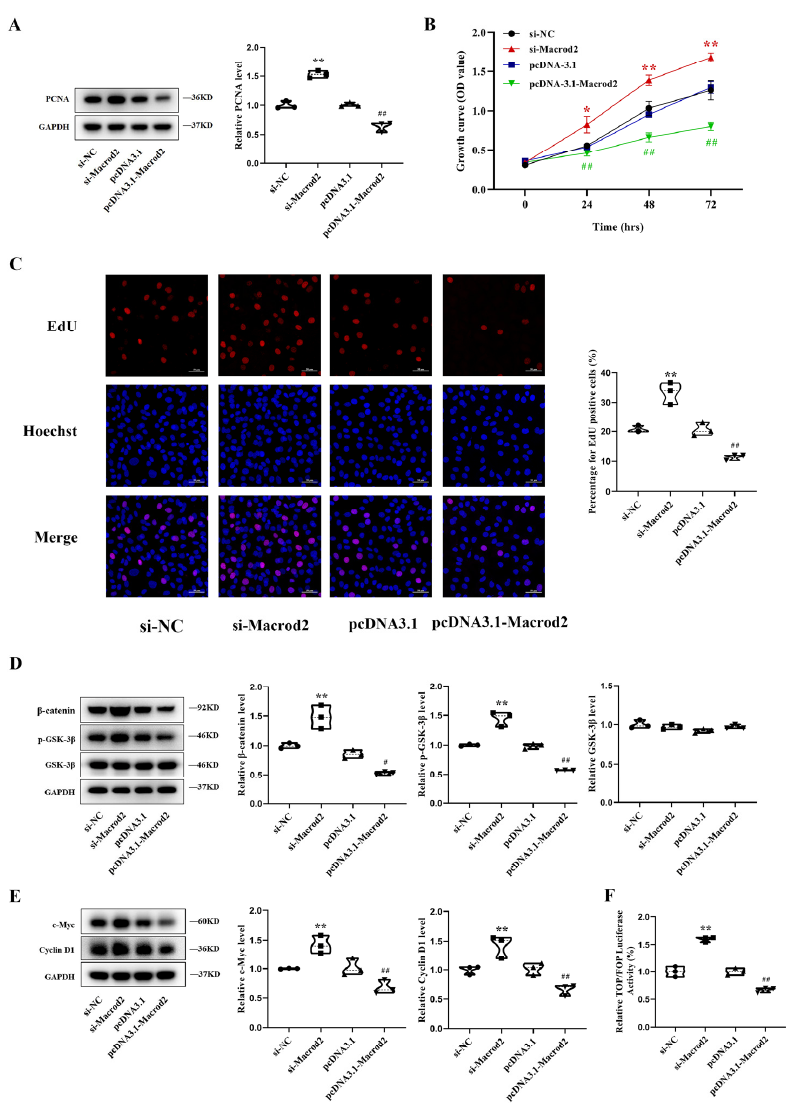
Figure 4. Macrod2 inhibits osteoblast proliferation in MC3T3-E1 cells. ( A ) Protein levels of PCNA in MC3T3-E1 cells by Western blotting in MC3T3-E1 cells transfected with si-Macrod2, pcDNA3.1- Macrod2, or the corresponding controls ( n = 3). One-way ANOVA followed by LSD’s multiple comparisons test. ( B ) Cell proliferation as assessed by a CCK-8 assay in MC3T3-E1 cells in the indicated groups ( n = 3). Repeated measures ANOVA. ( C ) The EdU positive cells showed by EdU labeling assays after treatment with si-Macrod2, pcDNA3.1-Macrod2, or the corresponding controls in MC3T3-E1 cells ( n = 3). Scale bar, 50 μ m. One-way ANOVA followed by LSD’s multiple comparisons test. ( D ) Western blotting analysis of β -catenin, p-GSK-3 β , and GSK-3 β in MC3T3-E1 cells ( n = 3). One-way ANOVA followed by LSD’s multiple comparisons test. ( E ) Western blotting analysis for c-Myc and Cyclin D1 protein levels in MC3T3-E1 cells ( n = 3). One-way ANOVA followed by LSD’s multiple comparisons test. ( F ) Dual luciferase assay showing the effect on TOP/FOP reporter activity in MC3T3-E1 cells transfected by si-Macrod2 or pcDNA3.1-Macrod2 ( n = 3). One-way ANOVA followed by LSD’s multiple comparisons test. * p < 0.05 vs. the cells transfected with si-NC. ** p < 0.01 vs. the cells transfected with si-NC. # p < 0.05 vs. the cells transfected with pcDNA3.1. ## p < 0.01 vs. the cells transfected with pcDNA3.1.